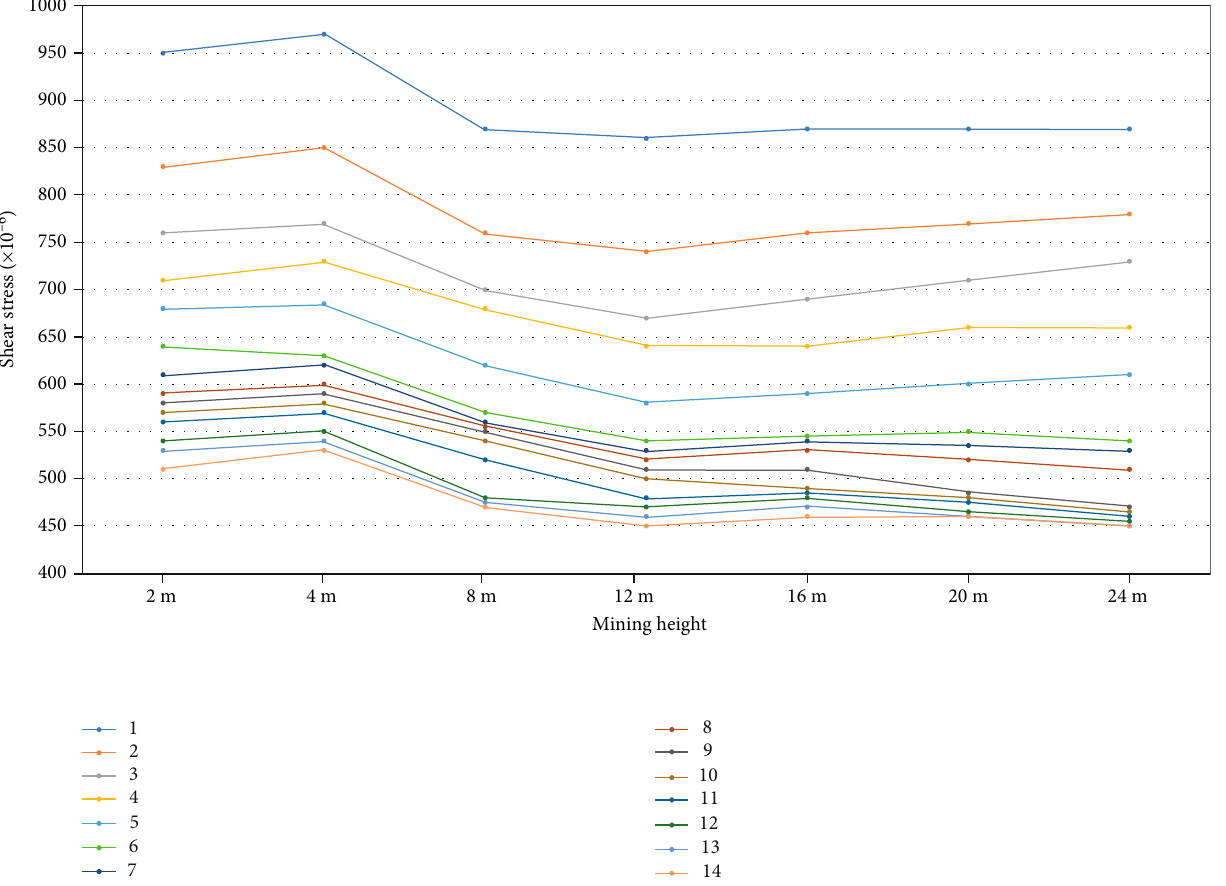
Figure 9: Variation of shear strain with mining height in the monitoring area (1 ~ 14). Table 2: Depth of the fl oor failure zone of the working face calculated according to statistical formulas. Source of formula Formula Depth of fl oor failure zone